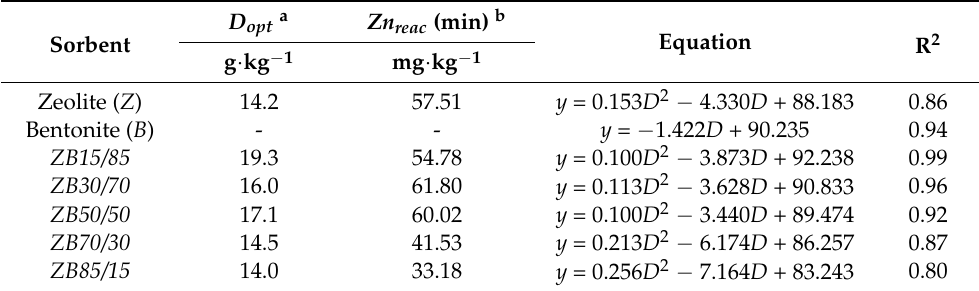
Table 6. Regression models elaborated for reactive Zn ( Zn reac ) fractions in treatments with sorbents after 115 days of aging.